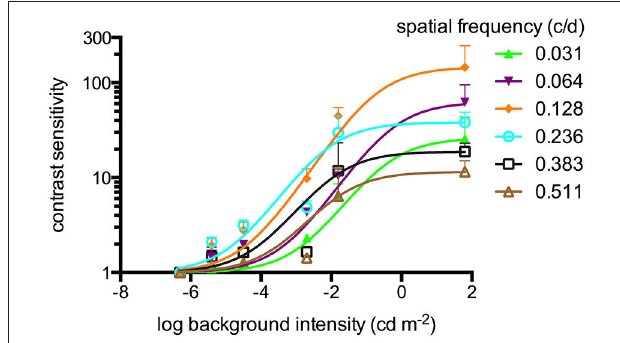
FIGURE 1 | Contrast sensitivities (sigmoidal curve fitting) of adult zebrafish ( n = 6 animals) at different light intensities at a constant temporal frequency of 1.5 cycles/second (c/s) . An optokinetic response (OKR) was not observed at the lowest light intensity tested ( − 6.3 log cd m − 2 ). Above his light level, increasing contrast sensitivity (CS) was observed for increasing luminance at all tested spatial frequencies. Error bars indicate the standard deviation.